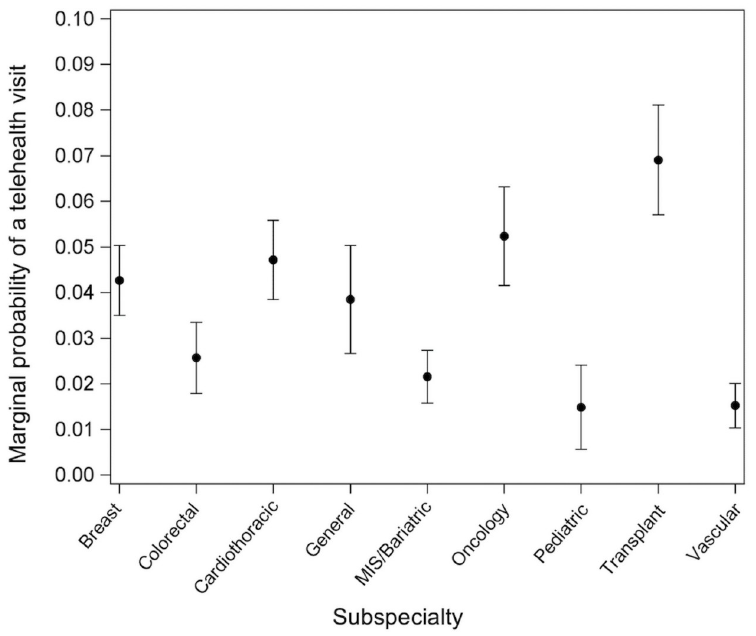
Fig 1. Probability of telemedicine visit during COVID-19 by surgical subspecialty. Marginal probability of a telemedicine visit during COVID-19, compared to visits before COVID-19, by surgical subspecialty.